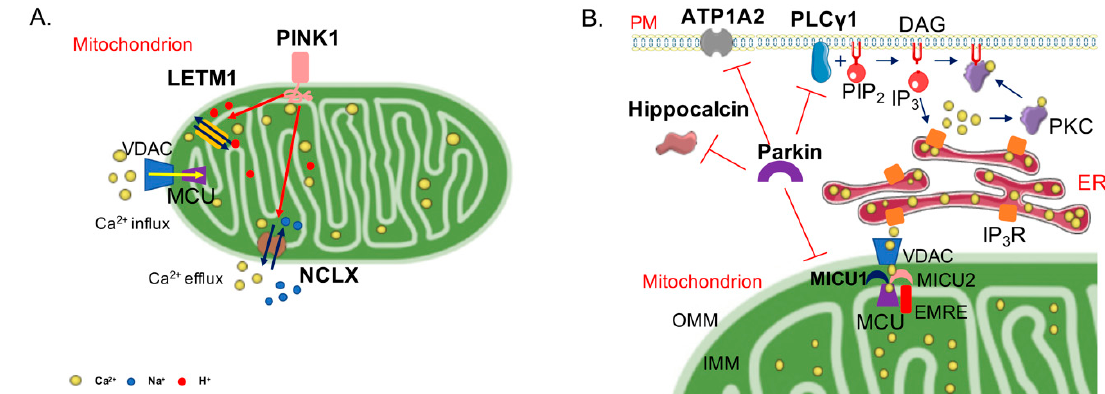
Figure 2. PINK1, Parkin, and Ca 2+ . (A ) PINK1 is involved in mitochondrial Ca 2+ handling. In fact, its depletion leads to mitochondrial Ca 2+ overload. The mechanisms underlying this PINK1 function are not clear, but it has been suggested as being a possible, controversial PINK1-dependent regulation of mitochondrial Ca 2+ influx via the modulation of Ca 2+ uptake or efflux via the modulation of the mitochondrial Na + /Ca 2+ exchanger (NCLX). PINK1 also phosphorylates the leucine zipper-EF-hand- containing transmembrane protein 1 (LETM1) by increasing its activity. (B) Parkin involvement in Ca 2+ homeostasis is more characterized. It regulates mitochondrial Ca 2+ uptake protein 1 MICU1 turnover, and indirectly also that of mitochondrial Ca 2+ uptake protein 2 (MICU2), whose stability depends on MICU1. MICU1 and 2 are the positive and negative regulators of the mitochondrial uniporter pore subunit (MCU), respectively. By decreasing MICU levels, Parkin is able to regulate mitochondrial Ca 2+ handling. Parkin also interacts with and ubiquitylate phospholipase C γ 1 (PLC γ 1), responsible for the generation of the second messenger inositol 1,4,5 trisphosphate (IP 3 ) and diacylglycerol (DAG). Parkin deficiency leads to a PLC-dependent increase of intracellular Ca 2+ levels, possibly due to excessive activation of PLC γ 1. Two additional Parkin substrates have been recently identified: the ATPase Na + /K + transporting subunit alpha 2 (ATP1A2), possibly involved in modulating Ca 2+ dynamics, and Hippocalcin, a Ca 2+ sensor that can also regulate voltage-dependent Ca 2+ channels.